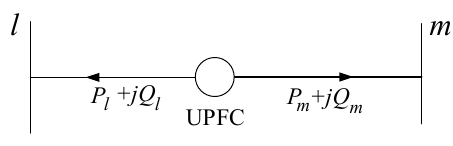
Figure 8. Power injection model of the UPFC.